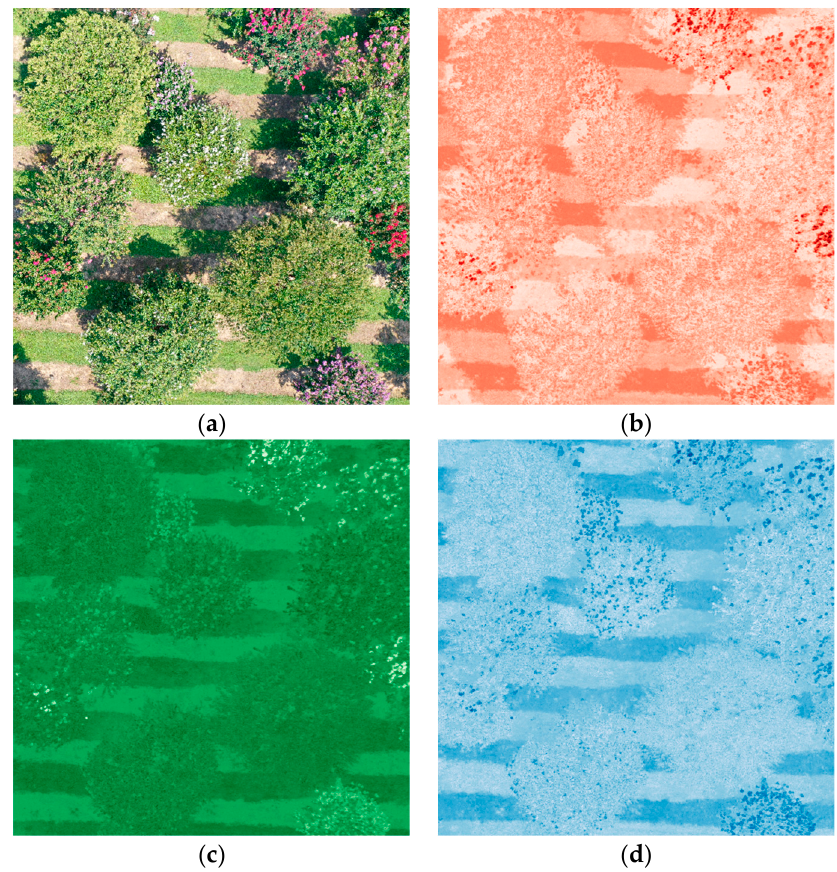
Figure 2. Original RGB and false color images of a crapemyrtle ( Lagerstroemia spp.) field plot at the TSU Otis L. Floyd Nursery Research Center in McMinnville, TN captured with a UAS: ( a ) original RGB image; ( b ) excess red (ExR); ( c ) excess green (ExG); and ( d ) excess blue (ExB). Vegetation indices were visualized through a simple Python script written by the author.